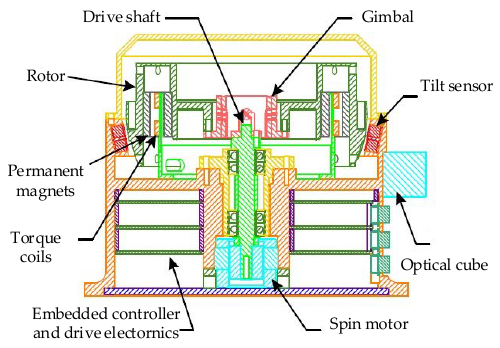
Figure 1. Cross-sectional view of the GyroWheel system.